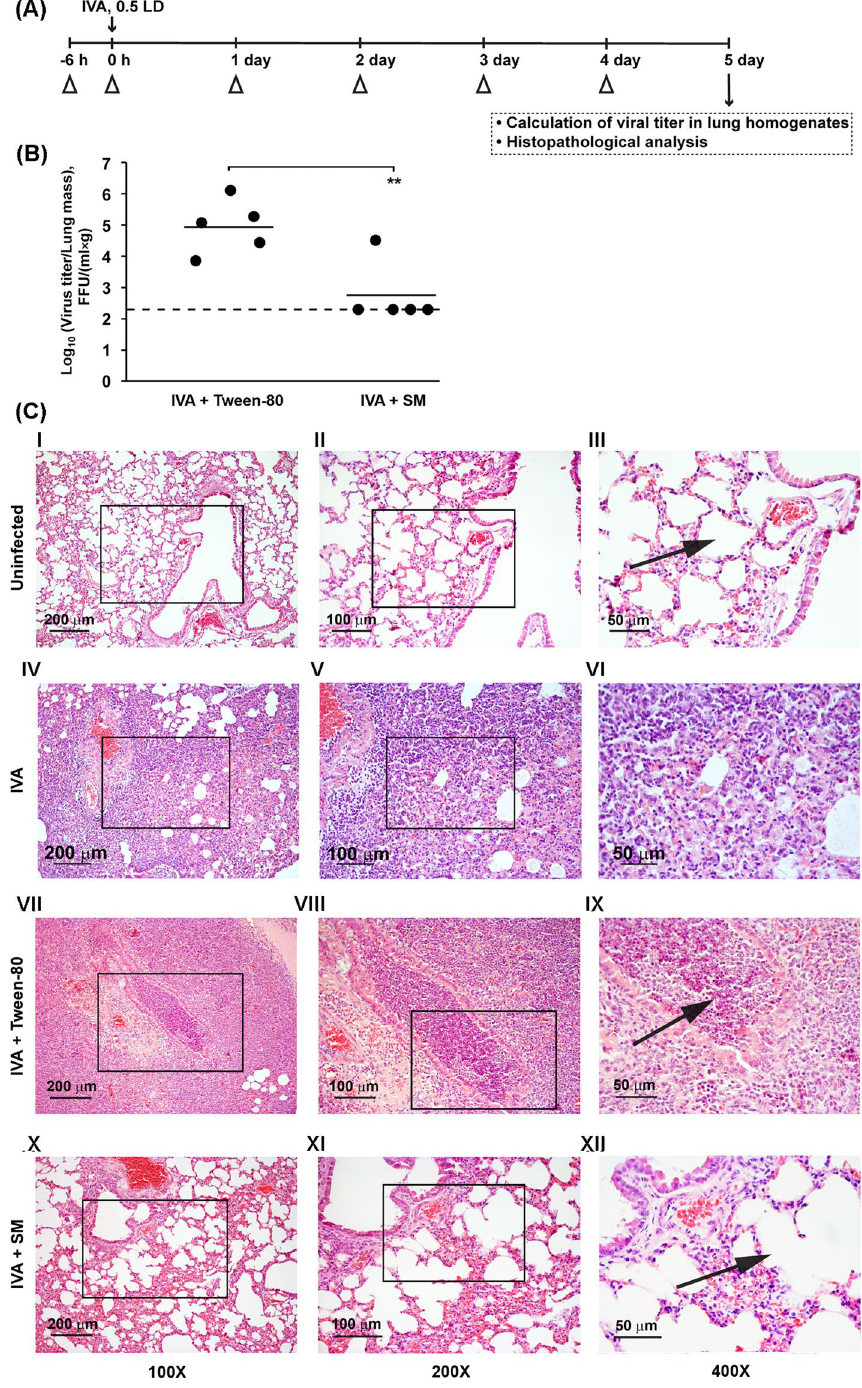
Figure 6. Intranasal treatment with SM prevents the development of non-lethal IVA infection in mice. ( A ) Scheme of the experiment. BALB/c mice were infected with IVA (0.5 LD) at 0 h, marked by an arrow. Infected mice were intranasally treated with vehicle (10% Tween-80) or 5 mg/kg of SM at the indicated time points ( ∆ ). On day 5 after infection, mice were weighed and euthanized and lung tissues were collected. (B) Virus titers in the lungs of mice that received intranasal treatment with SM on day 5 after IVA infection. Mean virus titers are shown by the horizontal bars. Dotted line represents the limit of sensitivity of the assay. The difference between SM-treated and Tween treated groups is statistically significant ( ** p < 0.01). (C) The effect of SM on the lung tissue of IVA-infected mice. Representative histological images of lung tissue of uninfected animals (I-III), IVA-infected animals (IV–VI), IVA-infected animals intranasally treated with 10% Tween-80 only (VII-IX) or with SM in 10% Tween-80 (5 mg/kg) (X–XII). Histopathological analysis revealed that untreated infected mice had severe diffuse pneumonia and severe bronchiolitis/peribronchiolitis, characterized by neutrophil- dominant inflammatory cellular infiltration (VI and IX, arrow). The intranasal administration of SM led to